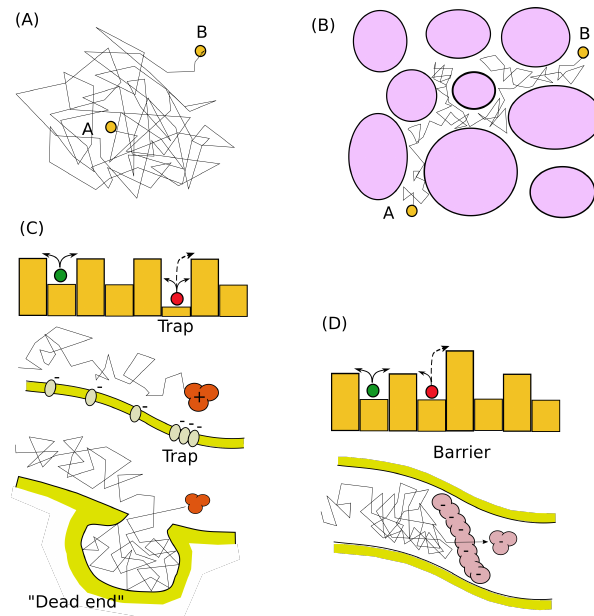
Figure 1. ( A ) The free diffusion process represented by a single particle trek (random walk) from point A to point B; ( B ) The random walk through obstacles can be treated as free diffusion over a longer distance using effective diffusion coefficient and tortuous parameter; ( C ) The theoretical model of trapping implies the existence of low-potential sites which are difficult for a particle to escape. It may be represented either by the locally charged molecules or by ”dead ends” of extracellular space; ( D ) The theoretical model of the barrier assumes the presence of a region that requires high energy to overcome it. In extracellular space, it may have the form of large charged molecules of the extracellular